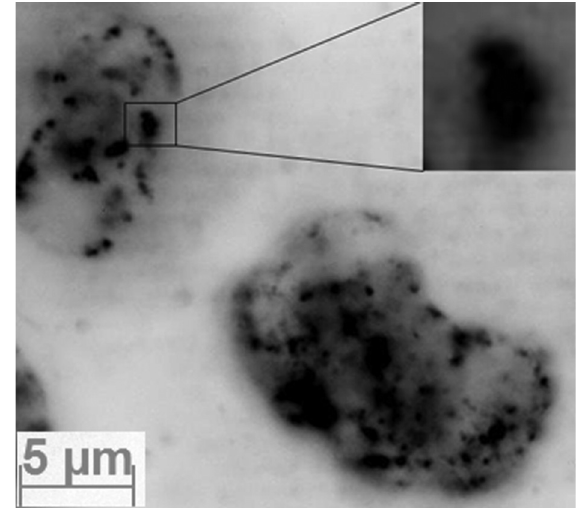
Figure 7 - Micrograph of HTB140 cell nuclei irradiated with 12 Gy γ -rays, showing overlapping foci, captured with AxioVision comprising ApoTome